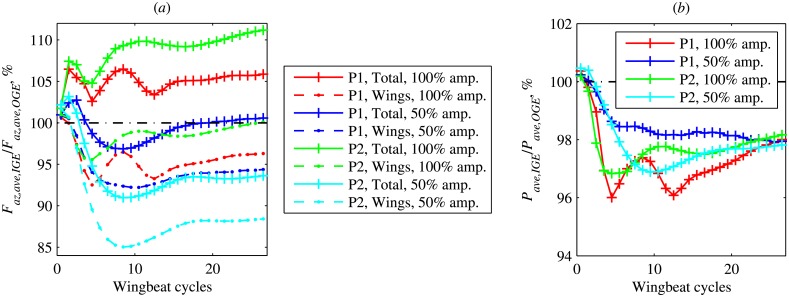
Hovering flight.(a) The ratio of wingbeat averaged vertical force IGE to OGE, Fz,ave,IGE/Fz,ave,OGE. (b) The ratio of wingbeat averaged power IGE to OGE, Pave,IGE/Pave,OGE.